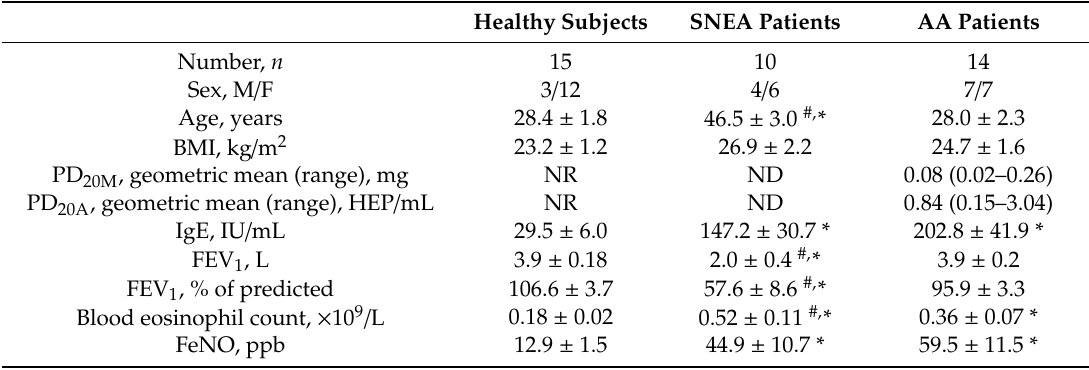
Table 1. Demographic and clinical characteristics of the study population. Healthy